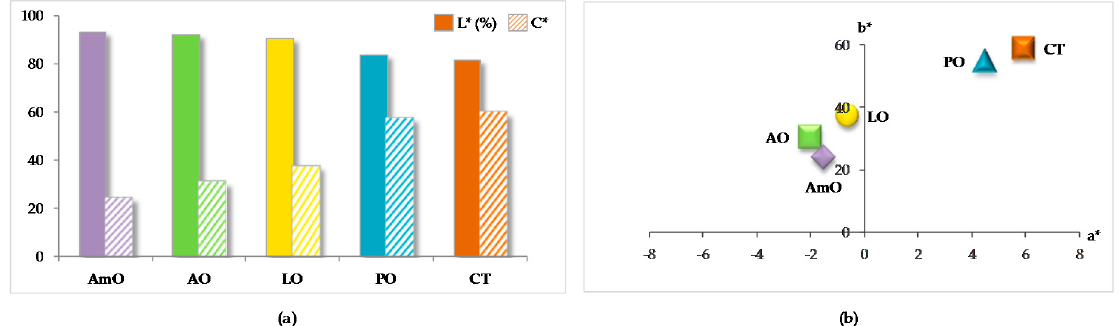
Figure 2. Mean values ( n = 24) of chromatic characteristics of the wine brandies aged in different kinds of wood: ( a ) lightness (L*) and saturation (C*); ( b ) chromaticity coordinates (a*, b*); AmO—American oak; AO—Allier oak; LO—Limousin oak; PO—Portuguese oak; CT—Chestnut. For each chromatic characteristic, the differences between the aged wine spirits are very significant ( p < 0.01). Adapted from [23].